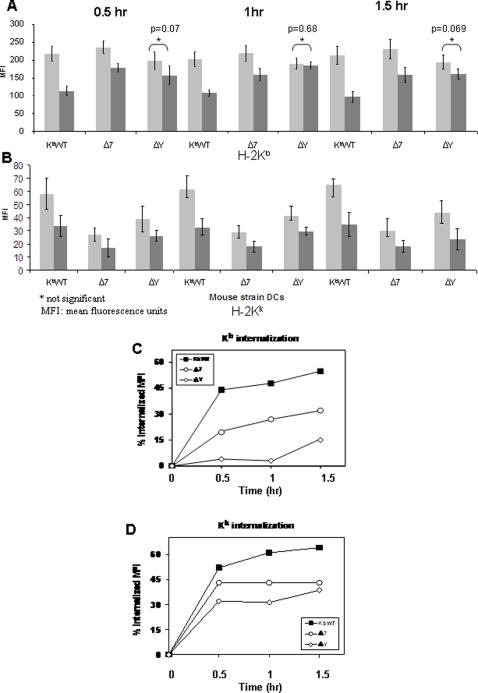
Quantification of MHC-I internalization in DCs.The dynamics of MHC Class I internalization is assessed by the reduced mean fluorescence units of FITC-labeled H-2Kb surface expression. Following labeling with (A and C) FITC-conjugated H-2Kb- or (B and D) PE-conjugated H-2Kk-specific antibodies and internalization at 37°C for the indicated time points, flow cytometric analysis was conducted to assess internalization of Kb and Kk molecules, as measured by the reduction in FITC and PE mean fluorescence intensities over time, respectively. Data are representative of 3 different experiments performed in triplicate.